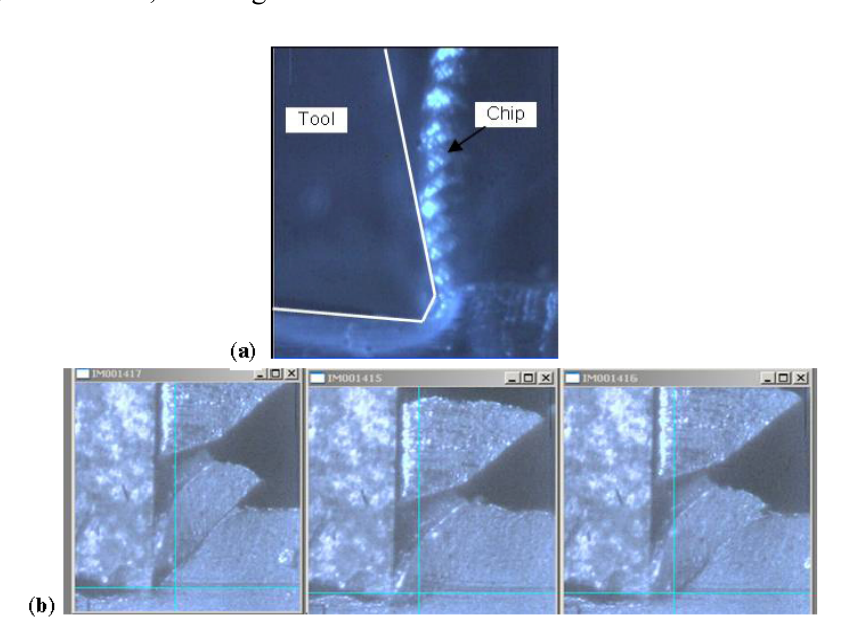
= 20 m/min, rake angle 0°, ( b ) segmentation c